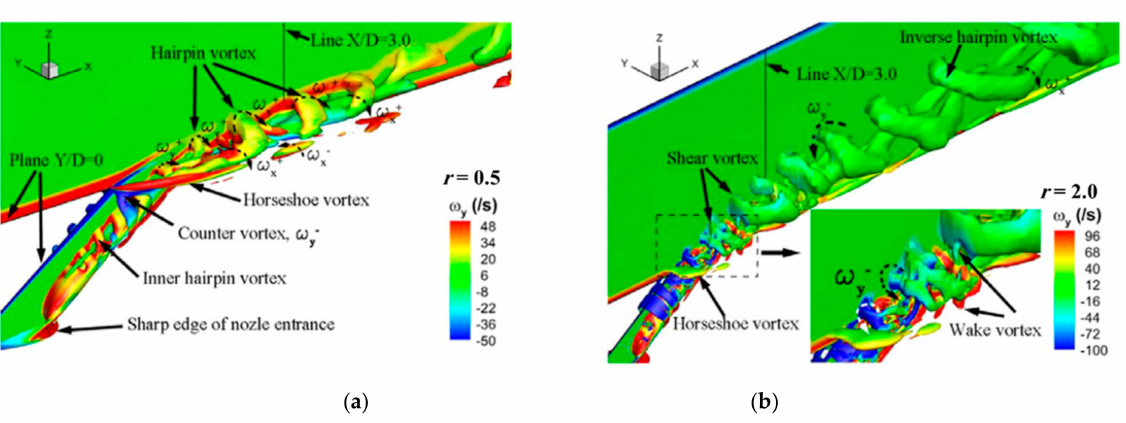
Figure 24. Spanwise vorticity ( ω y ) on iso–surfaces of: ( a ) ∇ 2P / ρ = 100/s2 for r = 0.5 and ( b ) ∇ 2P / ρ = 50/s2 for r = 2.0 [22].